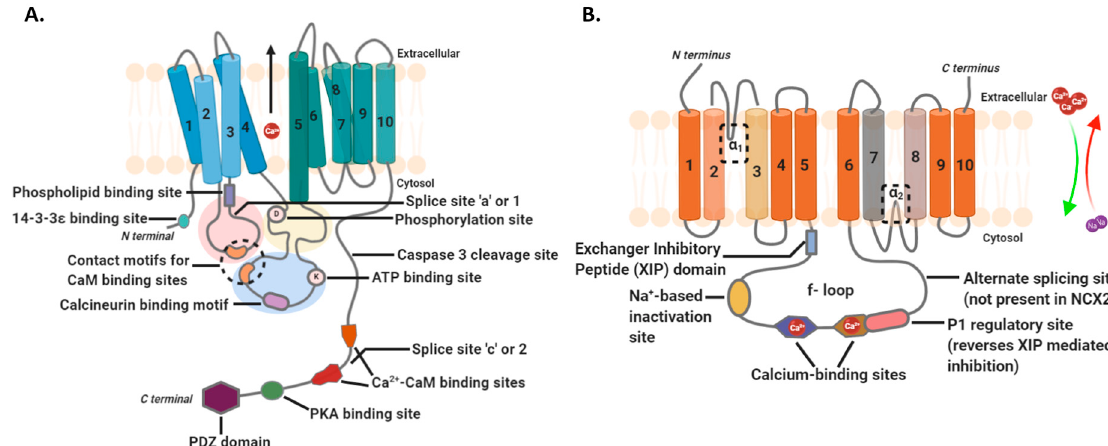
Figure 4. Structures of intracellular Ca 2+ efflux machinery. ( A ) Plasma membrane Ca 2+ -ATPase (PMCA) is comprised of cytosolic N- and C-termini, two Ca 2+ -binding sites (akin to SERCA; not shown here), and 10 transmembrane (TM) segments. Between the N- and C-tails lie three loop structures named like the domains in SERCA—A domain (red circle between TM 2–3), P domain (blue circle between TM 4–5), and N domain (yellow circle between TM 4–5) [34,36–40]. Various binding motifs and regulatory or interaction sites exist on each terminus and cytosolic domain with variations observed in their presence between PMCA isoforms and splice variants. Ca 2+ -bound calmodulin or Ca 2+ -CaM is a major regulator for all PMCA family members. The proximity of Ca 2+ -CaM binding sites on the C-tail to their corresponding motifs in A- and N-domains determine the open or closed states of the pump; ( B ) Sodium–Ca 2+ exchanger (NCX) also has a ten transmembrane topology with N- and C-tails facing the extracellular space [42–45,49]. The cytosolic side consists of an f-loop (between TM 5-6) that has two Ca 2+ ion binding sites, an alternate splicing site, a regulatory site, a sodium ion-dependent inactivation site, and an inhibitory domain. The structure also has two conserved alpha-helical repeats ( α 1 and α 2) that influence ion binding and transport. ATP, adenosine triphosphate; CaM, calmodulin; NCX2, sodium-Ca 2+ exchanger 2; PKA, protein kinase A; PDZ, a structural domain; XIP, exchanger inhibitory peptide.